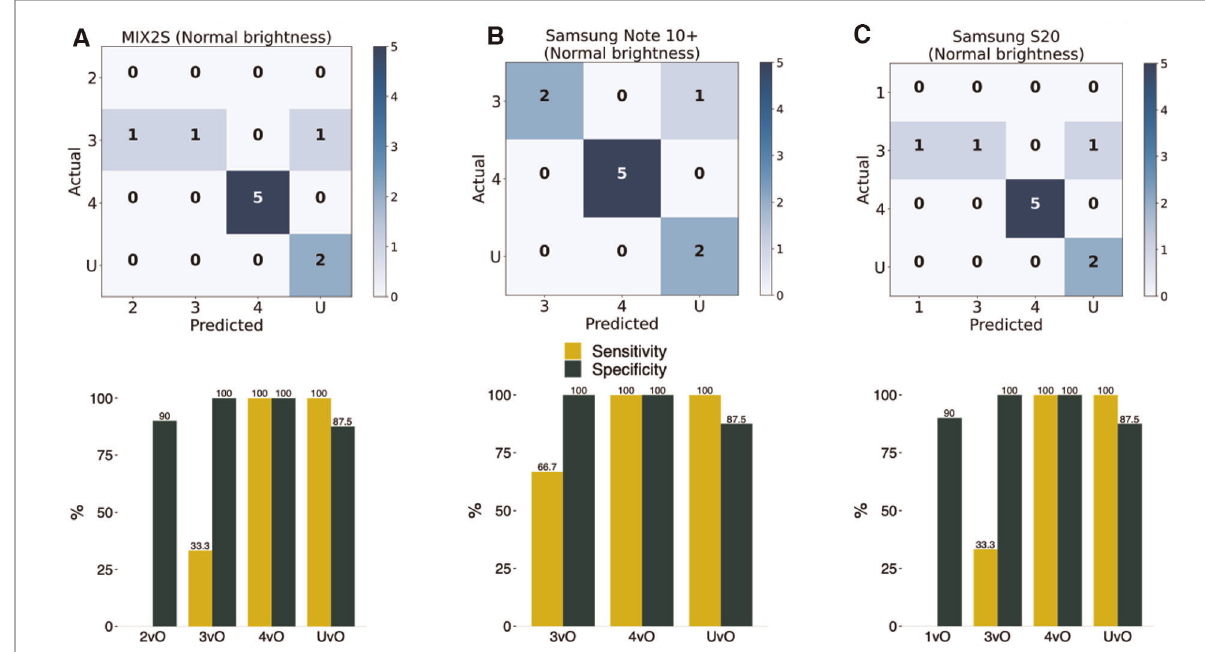
FIGURE 4 Evaluation of accuracy of the implemented model in an Android smartphone app. The detection and classi fi cation of the printed wound images in the 10 photos in the test set using the smartphone app with three different Android phones at normal (125 lux) brightness level: ( A ) MIX2S, ( B ) Samsung Note 10+, and ( C ) Samsung S20. 1vO: Stage 1 vs. Others; 2vO: Stage 2 vs. Others; 3vO: Stage 3 vs. Others; 4vO: Stage 4 vs. Others; UvO: Unstageable vs. Others.